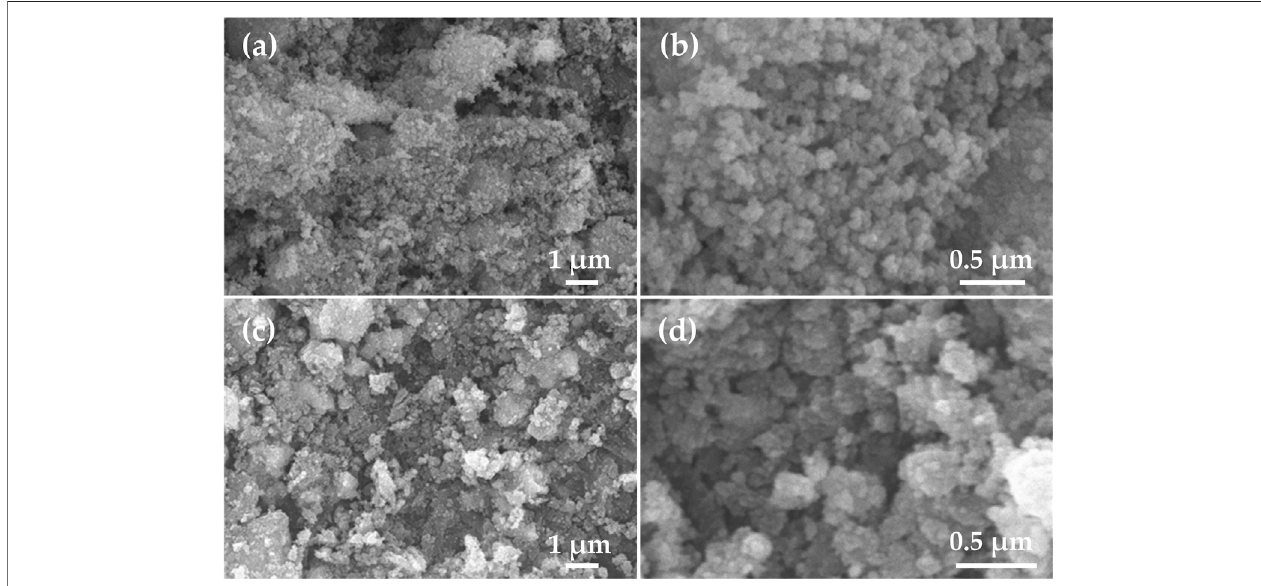
FIGURE 2 | SEM images of SnO 2 (A , B) and SnO 2 -P (C , D) .